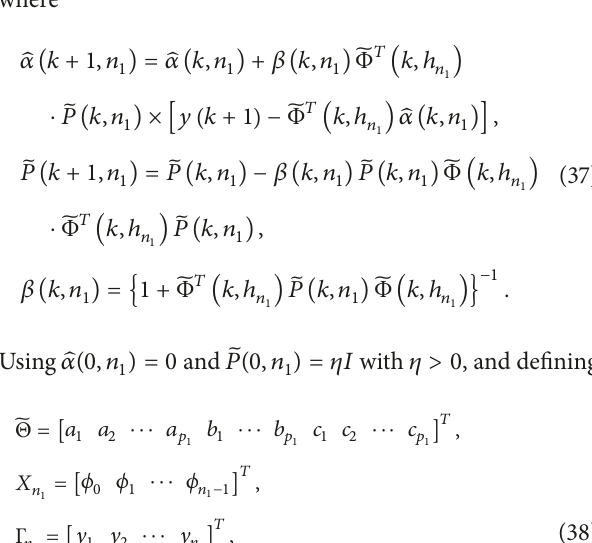
Table 1: Test compressor design